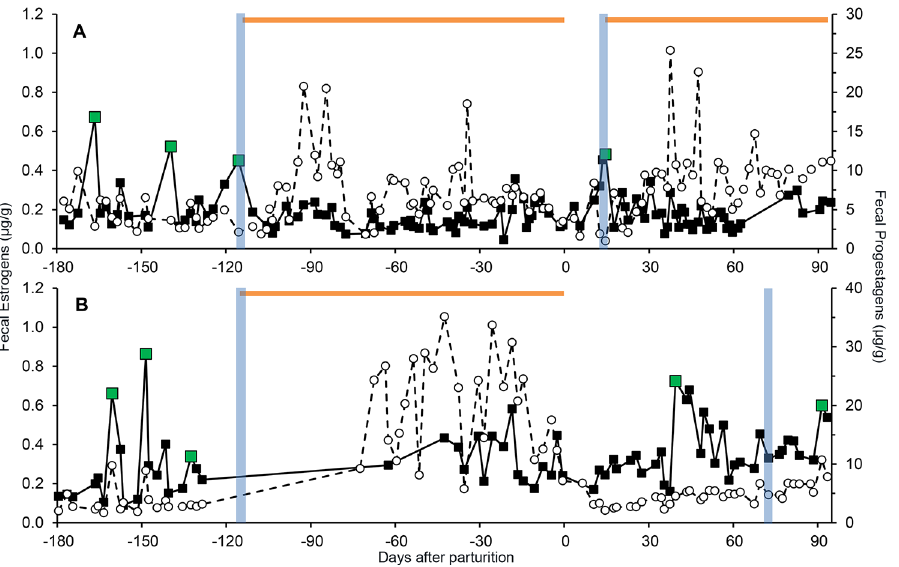
Fig 4. Longitudinal steroid hormone profiles ( μ g/g feces, FEM; filled squares, FPM: open circles, dashed line) showing the resumption of cycling post-partum in a female that lost her cub (SB246, Panel A) and a female with a surviving litter (SB341, Panel B). Green data points denote estrous peaks, vertical blue bars indicate breeding, the purple arrow signifies death of a cub and horizontal orange bars represent